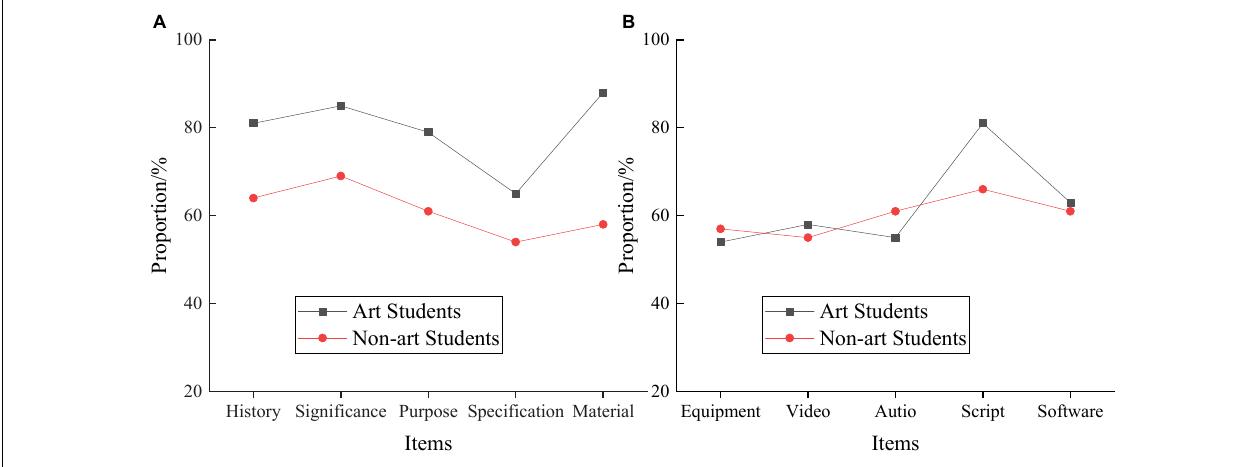
FIGURE 6 | Evaluation results of students of different artistic backgrounds. (A) Art students. (B) on-art students.